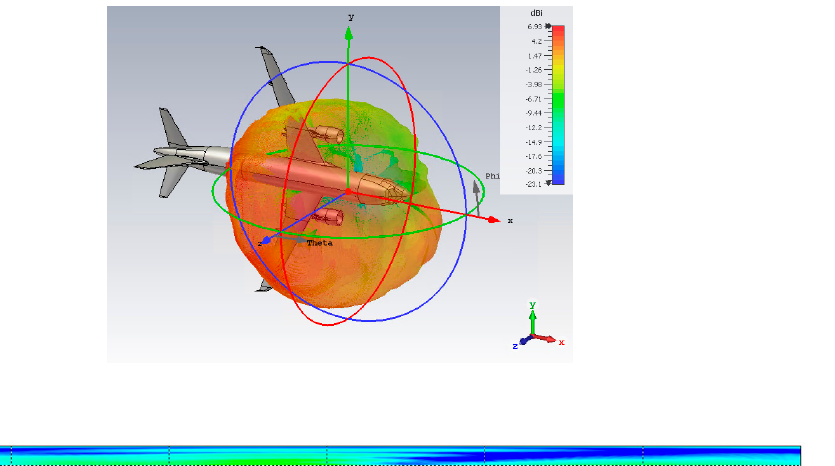
Figure 17. RHCP radiation pattern of the DLR antenna array in Mode 1 once mounted on an aircraft: ( top ) 3D view; ( bottom ) 2D view.